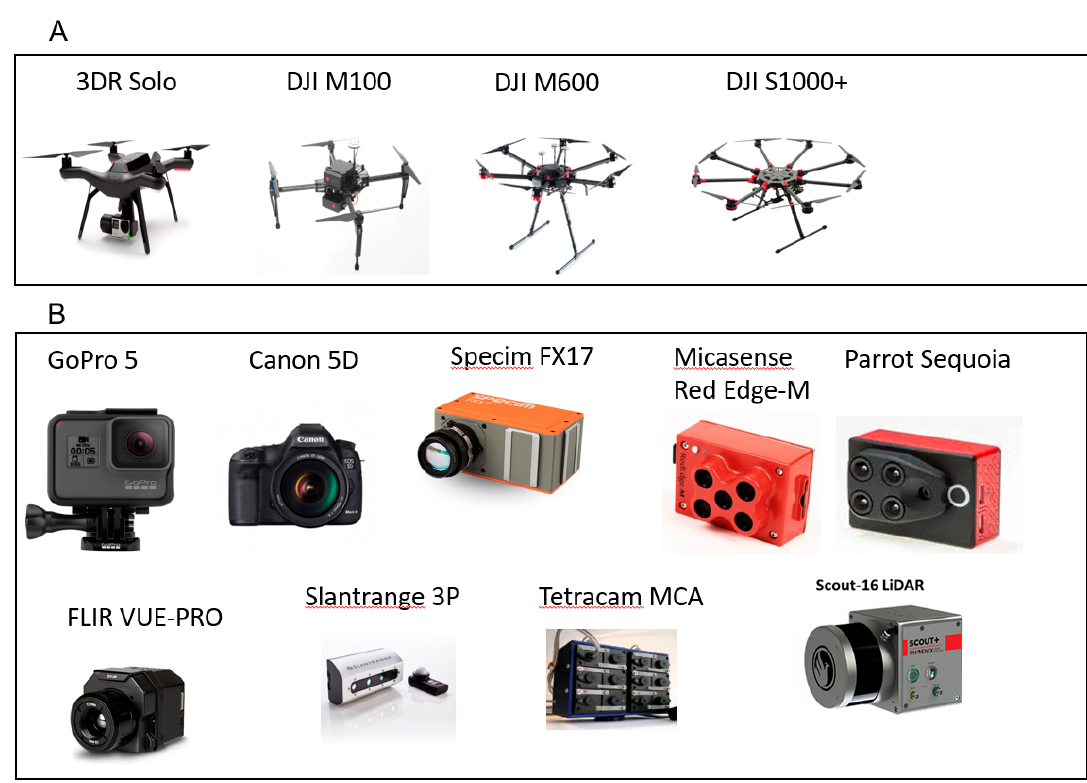
Figure 3. The aerial-based unmanned aerial system (UAS) phenotyping platform in Hamilton Centre, AVR for field phenotyping of perennial ryegrass. ( A ) List of various semiautomated UASs; ( B ) list of sensors deployed on UASs.